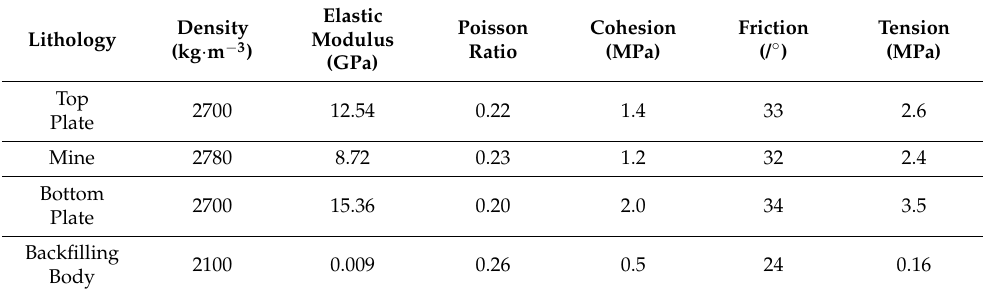
Table 3. Model calculation mechanics parameter list.